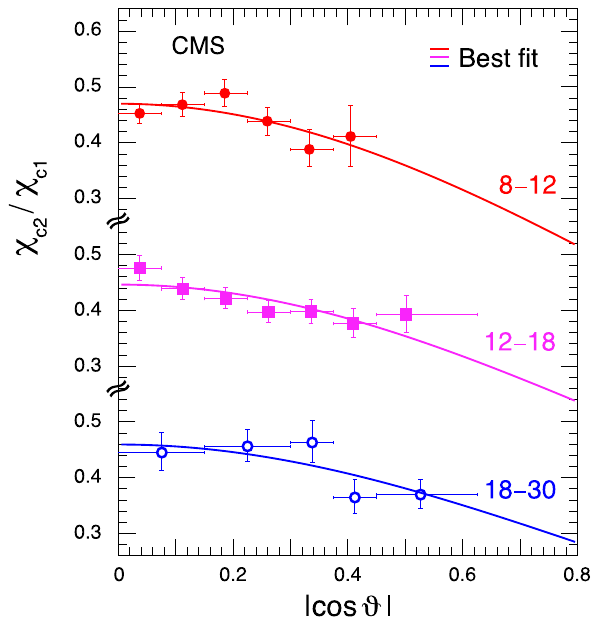
Fig. 3 The χ c 2 /χ c 1 yield ratio vs. | cos ϑ | (in the helicity frame), for three J /ψ p T bins (8–12, 12–18 and 18–30GeV), as measured by CMS √ s = 8TeV [30]. The curves represent the result of in pp collisions at the fit described in the